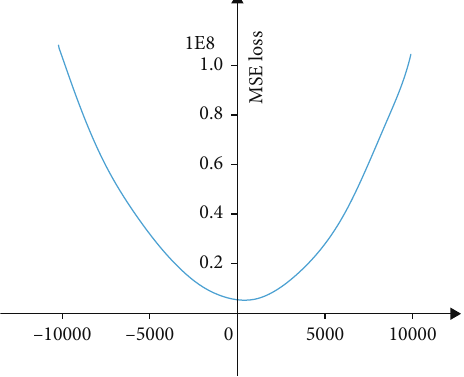
Figure 9: Image of mean square error loss